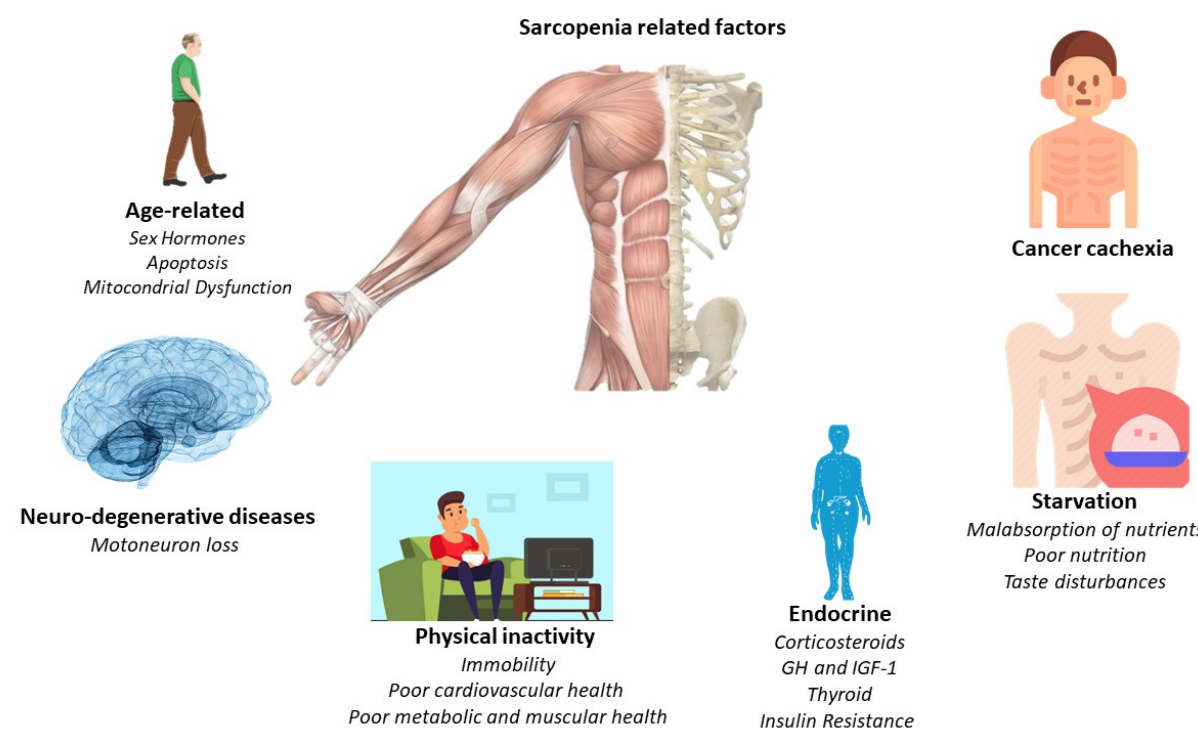
Figure 1. Principal sarcopenia-related factors.